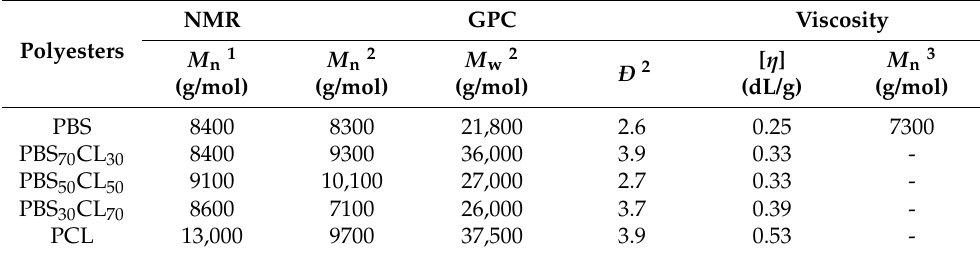
Table 2. Molecular weights and viscosities of PBS, PCL, and PBS x CL y